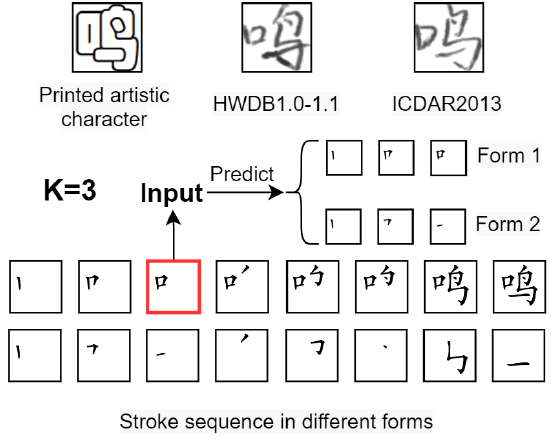
Figure 8. Examples of datasets. The last two lines of images are different forms of Chinese stroke